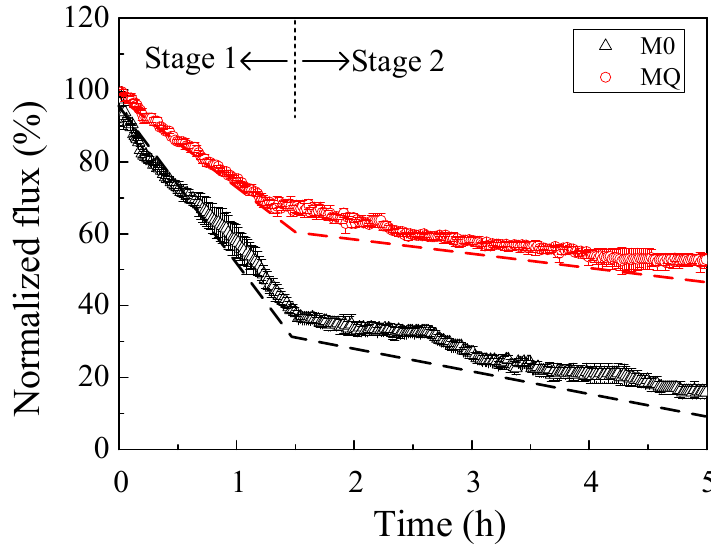
Figure 7. Normalized water flux of M0 and MQ due to biofouling by S. aureus . The initial bacterial concentration was 10 7 cells/mL. The dead-end filtration cell was operated at 10 kPa ( n = 3). The black and red dash lines represent decline tendency of M0 and MQ membranes.